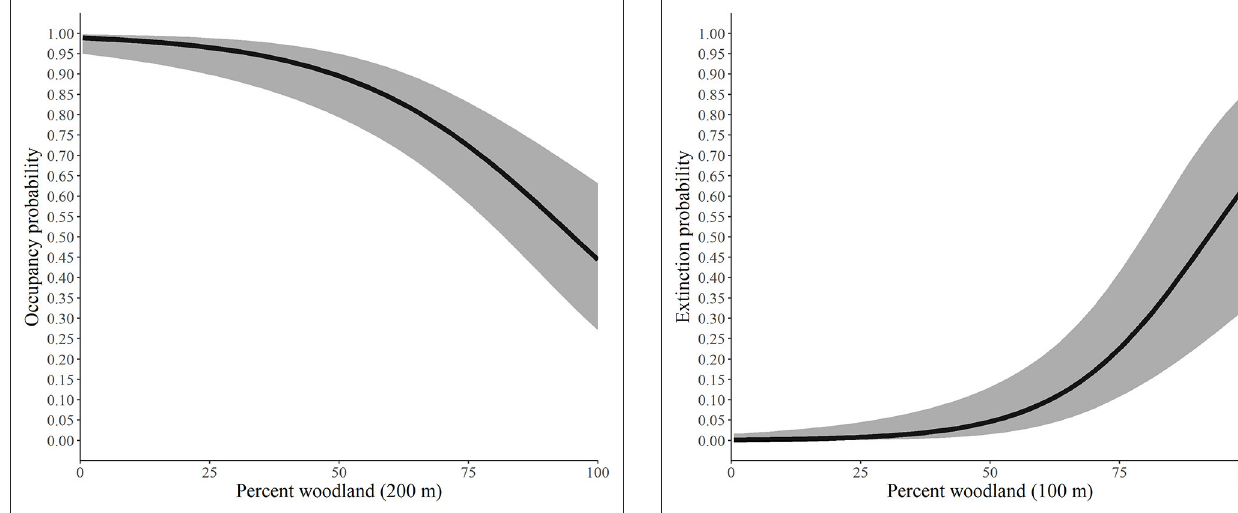
FIGURE 3 | Predicted probability of extinction by monarchs as a function of the percent of the landscape in woodland at the 100-m spatial scale, Iowa, 2006-2017. The solid line represents the predicted probabilities and the gray region is the 95% confidence envelope. Predictions are based on the